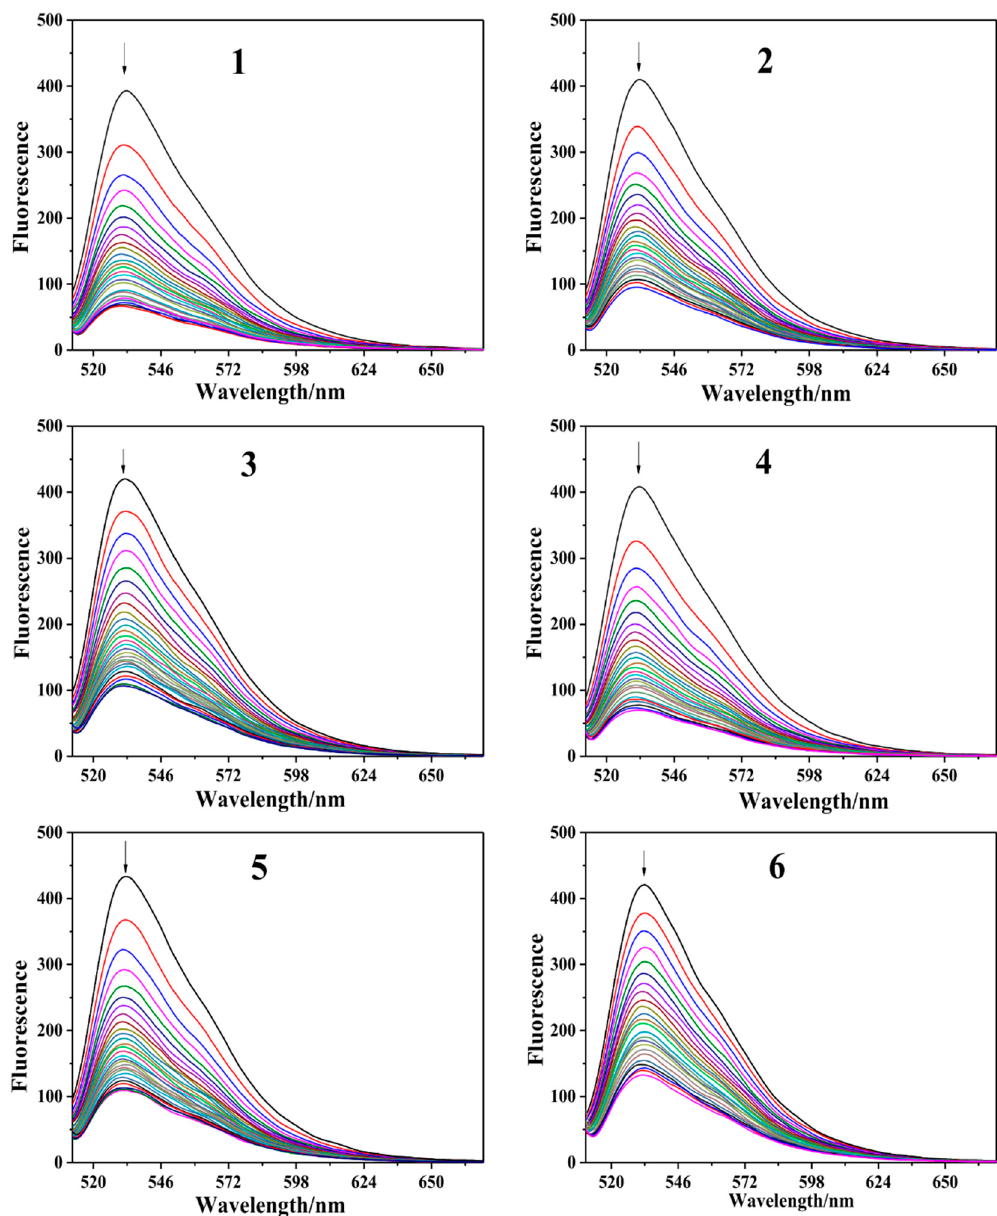
Figure 3. Thiazole orange (TO) displacement by arene Ru(II) complexes from c-myc G-quadruplex-TO adduct. The fluorescence spectra of the TO/G-quadruplex are obtained in a buffer containing 10 mM Tris-HCl, 100 mM KCl, pH 7.4 with increasing concentrations of arene Ru(II) complexes. [TO] = 1 µ M, [Ru] = 0–45 µ M, [ c-myc ] = 0.50 µ M, λ ex = 501 nm. Table 1. Concentrations of DC 50 values (Ru(II) complexes for the displacement of 50% of the TO from G-quadruplex DNA-TO complexes) for c-myc G-quadruplexes as determined from FID assays.